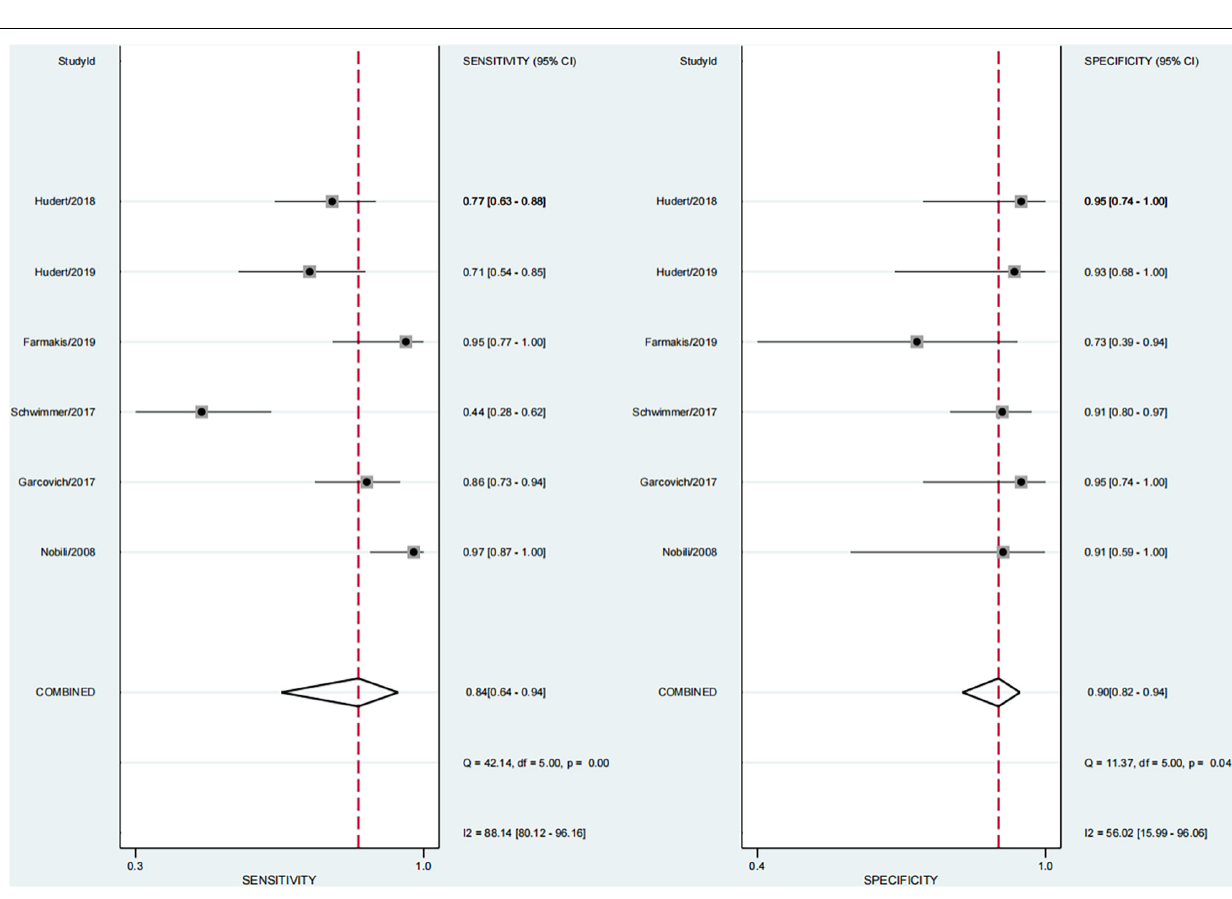
FIGURE 5 | Sensitivity and specificity of elastography in the diagnosis of any